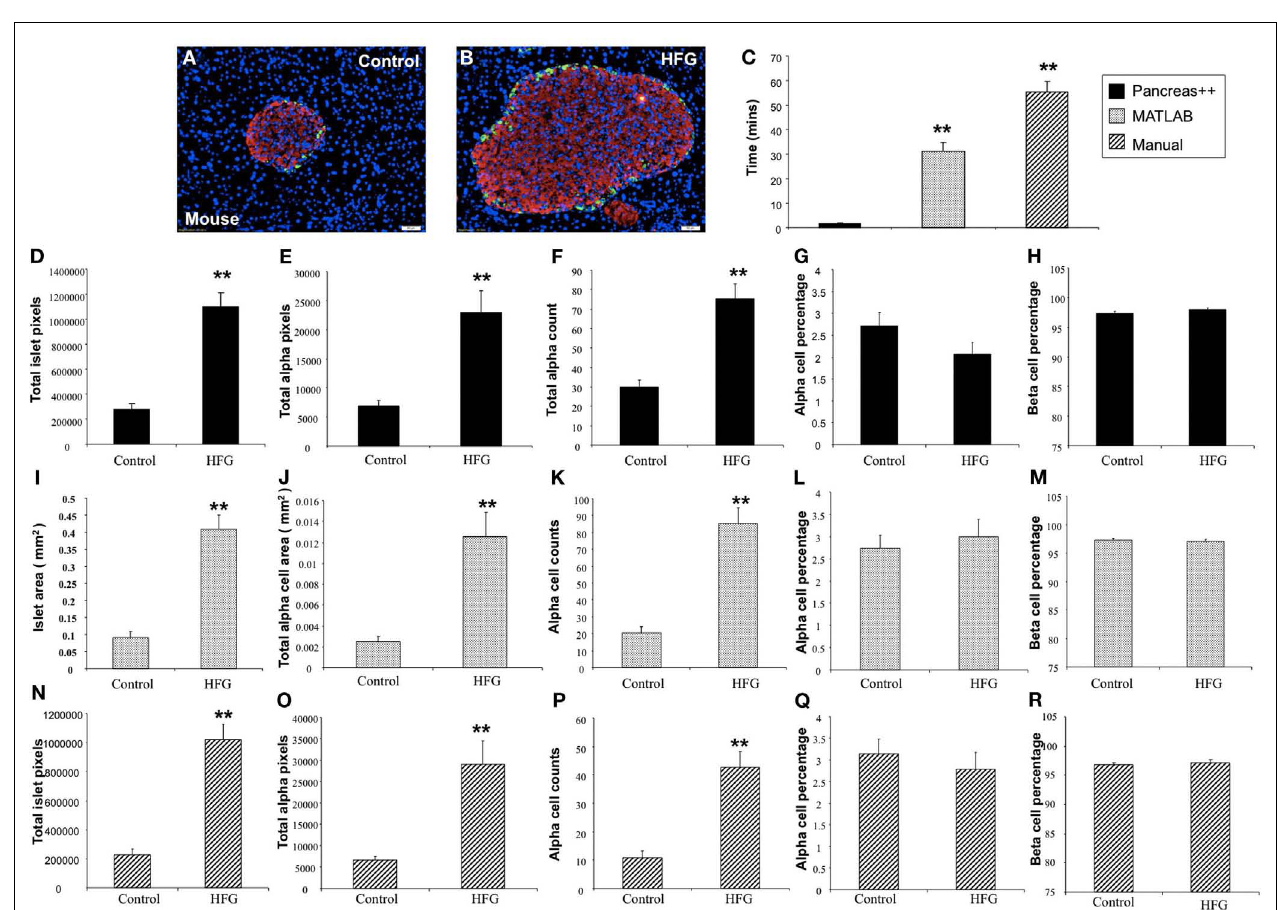
Pancreas ++ . Islet area (I) ; total alpha-cell area (J) ; total alpha-cell numbers (K) ; alpha-cell percentage (L) ; beta-cell percentage (M) of mice on control; and HFG diet analyzed by MATLAB showed the same pattern as the results analyzed by Pancreas ++ . Also islet area (N) ; total alpha-cell area (O) ; total alpha-cell numbers (P) ; alpha-cell percentage (Q) ; beta-cell percentage (R) of mice on control and HFG diet analyzed by manual methods showed the same pattern as the results analyzed by Pancreas ++ . Data are means ± SEM. ** p ≤ 0.01, n =